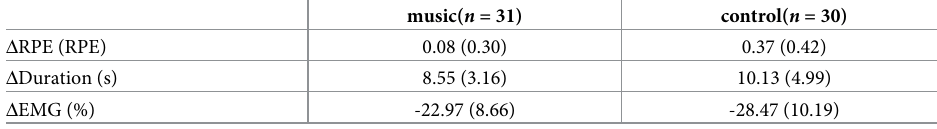
Table 3. Means and standard deviations for exercise planning and isometric grip task. Mean ( SD